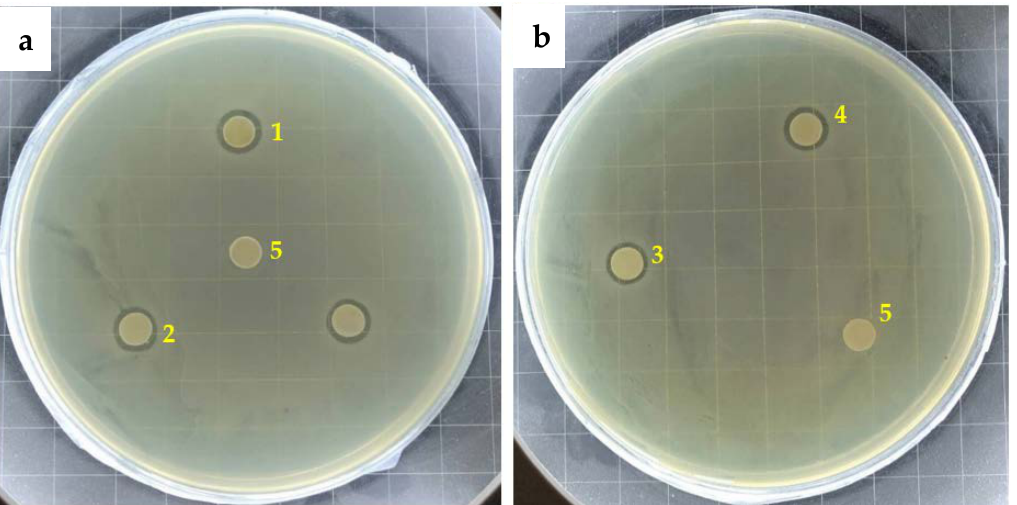
Figure 4. Inhibition zone of ( a ) additives with ex situ synthesized AgNP and ( b ) additives with in situ synthesized AgNP: 1. AgNPs(a)-Z; 2. AgNPs(a)-M; 3. AgNPs(b)-Z; 4. AgNPs(b)-M; and 5. Con- trol. Table 2. Inhibition zone diameters of the antibacterial